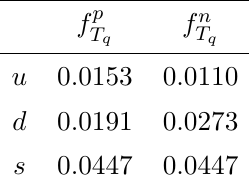
Table 1 . Nucleon form factors used in our calculation of the spin-independent cross section, which are the default values of micrOMEGAs 4.3.2